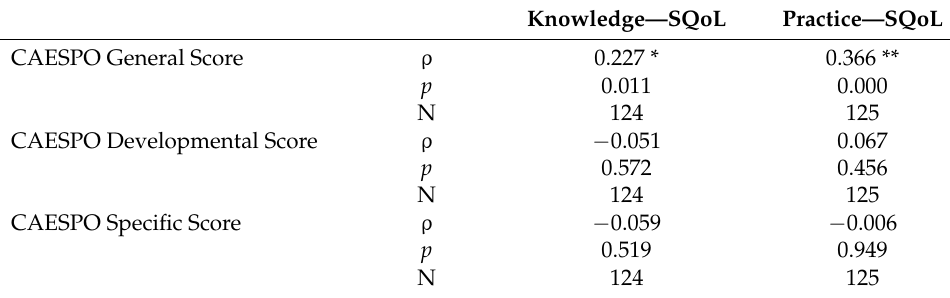
Table 4. Spearman Rho ( ρ ) Correlation CAESPO—STOMA